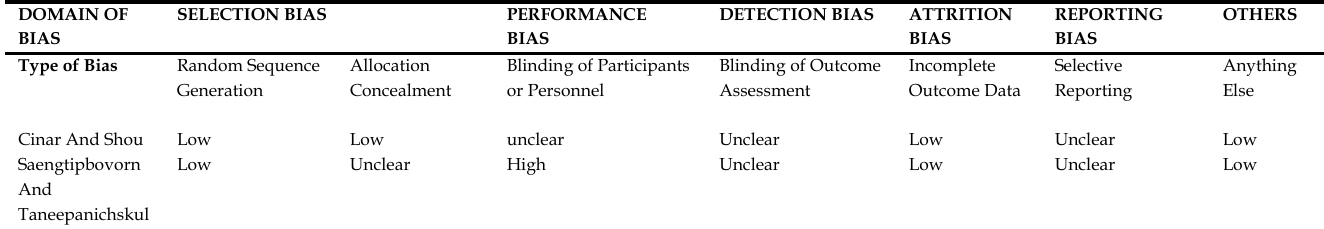
Table 2: Risk of Bias Summary Table DOMAIN OF